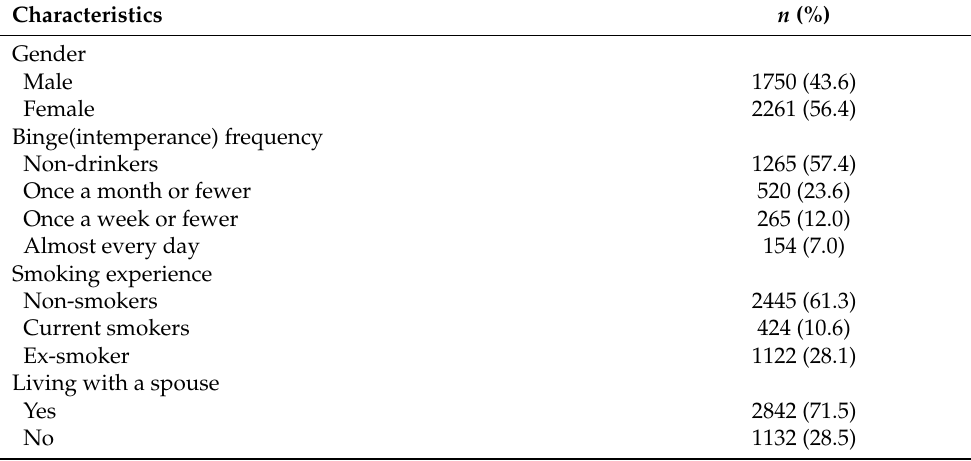
Table 1. General characteristics of the